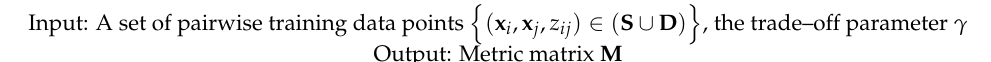
Algorithm 1 : Procedure of